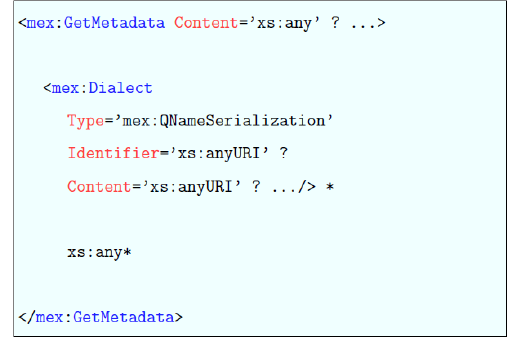
Figure 2. The <GetMetadata> Element.